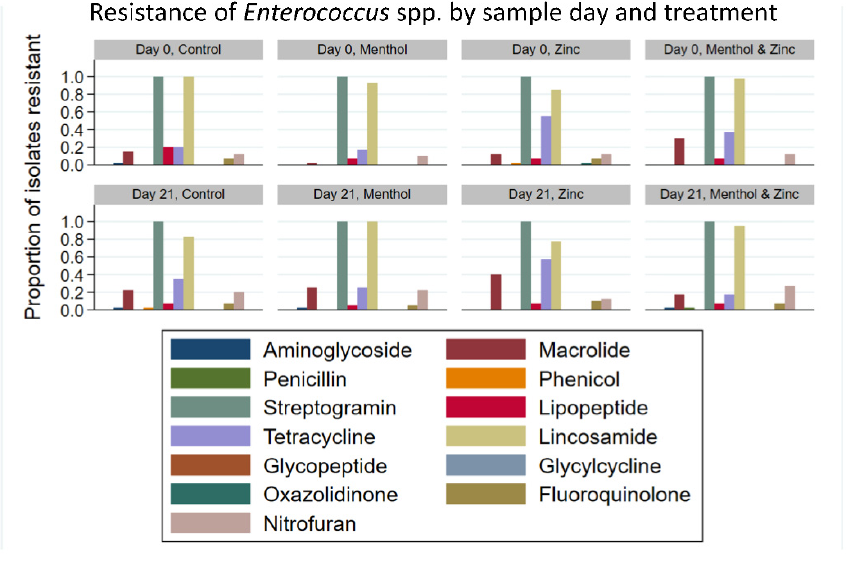
Figure 8. Resistance (proportion) of Enterococcus spp. isolates to each antibiotic class by sample day and treatment.